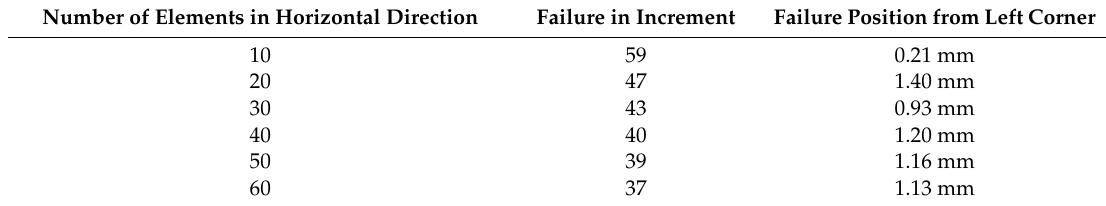
Table 1. Location and increment of failure